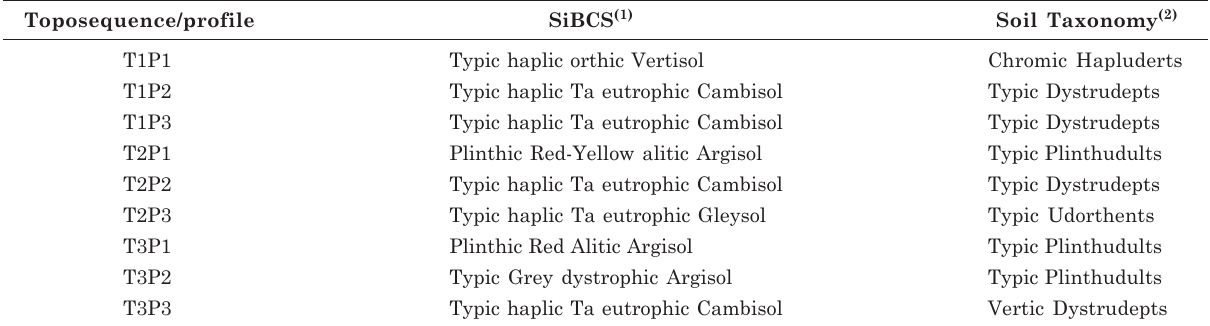
Table 1. Classification of the soil profiles studied using the Brazilian Soil Classification System (SiBCS) and Soil Toposequence/profile